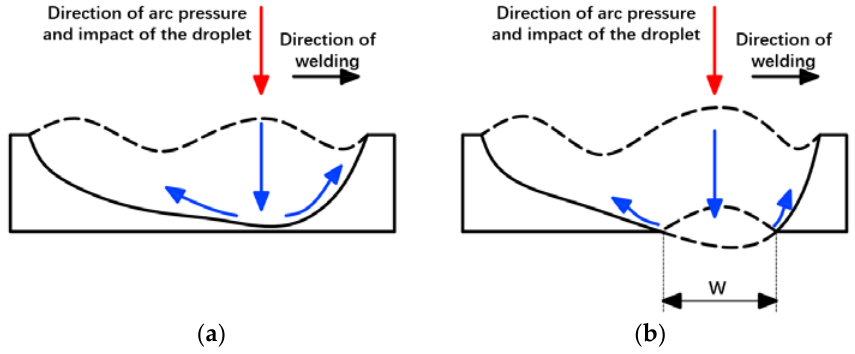
Figure 9. Oscillation mode of weld pool: ( a ) partial penetration; ( b ) full penetration.